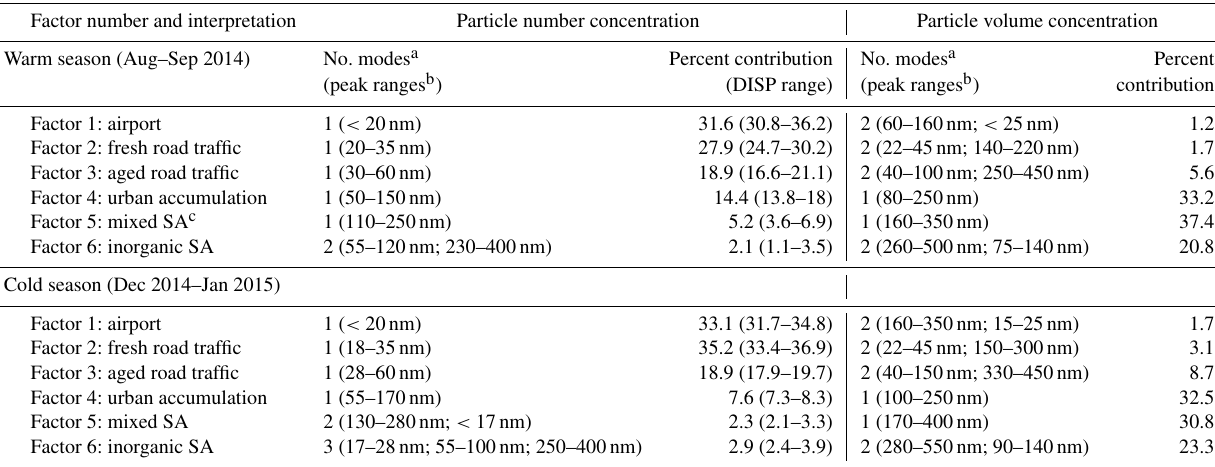
Table 1. Summary of PMF results for both